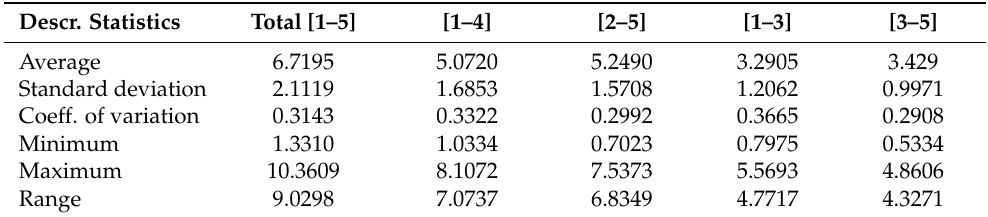
Table 5. The descriptive statistics of the mean WDVI cumulative values across all cumulative ranges and pilot fields.